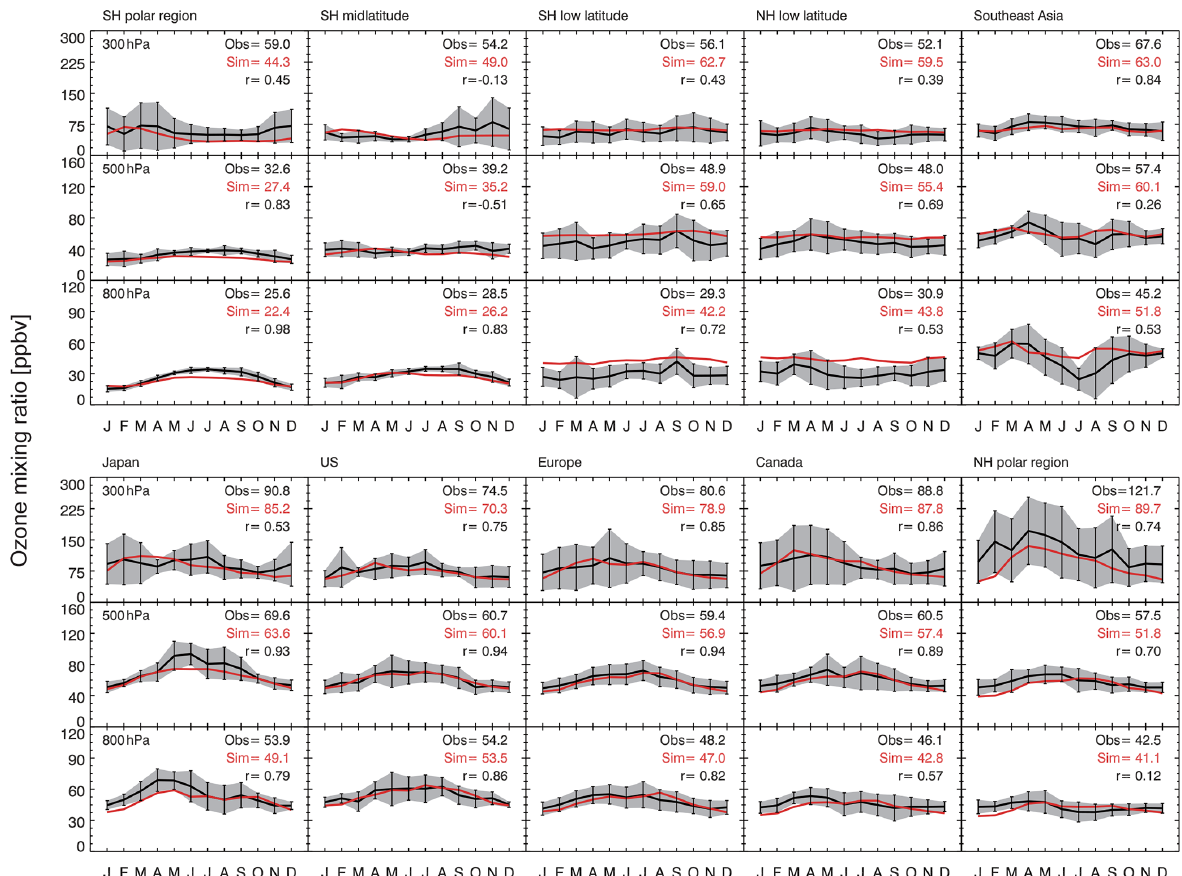
Figure 6. Seasonal variations of ozonesonde observed (black lines) and model simulated (red lines) ozone at three pressure levels (300, 500, and 800hPa) averaged over the 10 regions (Fig.3). Vertical black bars and gray shadings are the standard deviations of observations. The annual means of observed and simulated ozone concentrations and their correlation coefficients are shown inset. Values are 3-year averages over 2012–2014. Table 4. Global budget of tropospheric ozone diagnosed in BCC-GEOS-Chem v1.0 and comparison with other